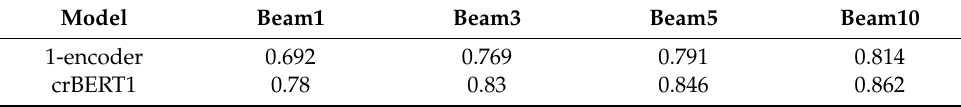
Table 3. BLEU experiment results for task 1.